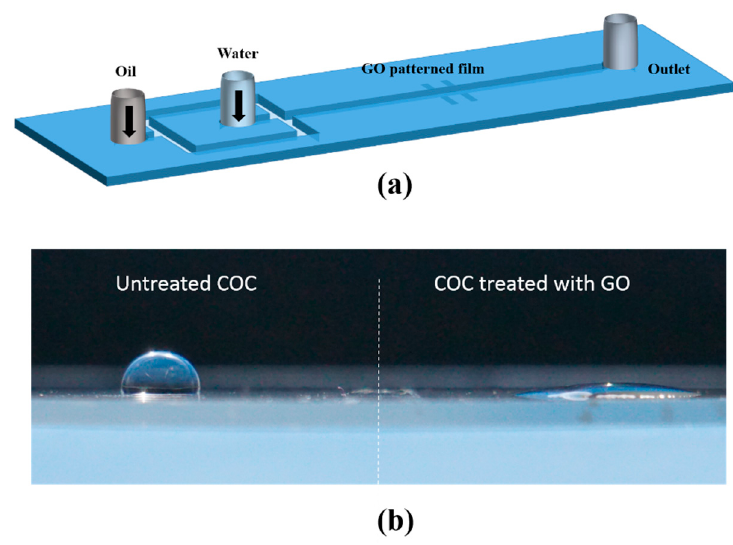
Figure 1. ( a ) A schematic of the Polydimethylsiloxane (PDMS)- Cyclic Olefin Copolymer (COC) microfluidic device with a flow focusing droplet generation scheme and a patterned wettability surface. ( b ) An image of the spreading of a water droplet on a COC substrate treated with graphene oxide (right) compared to a water droplet of the same volume standing on untreated COC (left).